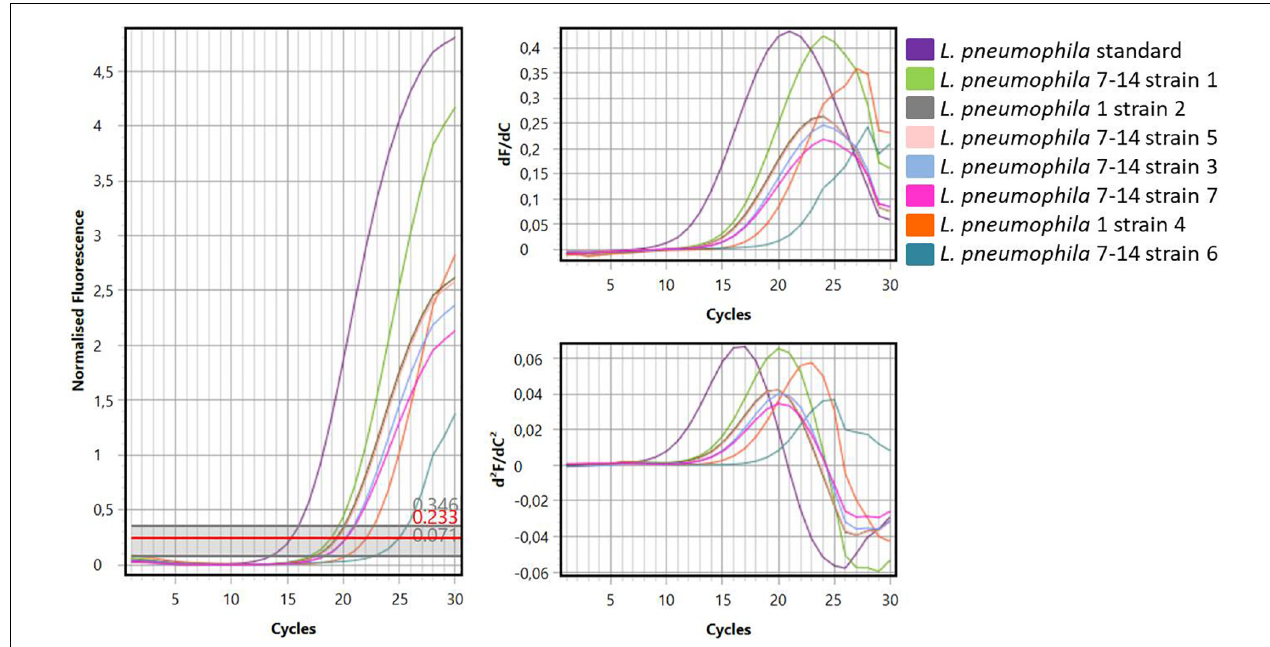
FIGURE 2 | Curves generated by amplification of standard Legionella DNA and DNA samples extracted from Legionella strains. TABLE 1 | Zones of inhibition measured in mm (diameter) caused by cell-free supernatants of Lactobacillus spp. (grown in MRS with the supplement glycerol) against Legionella spp. Strains